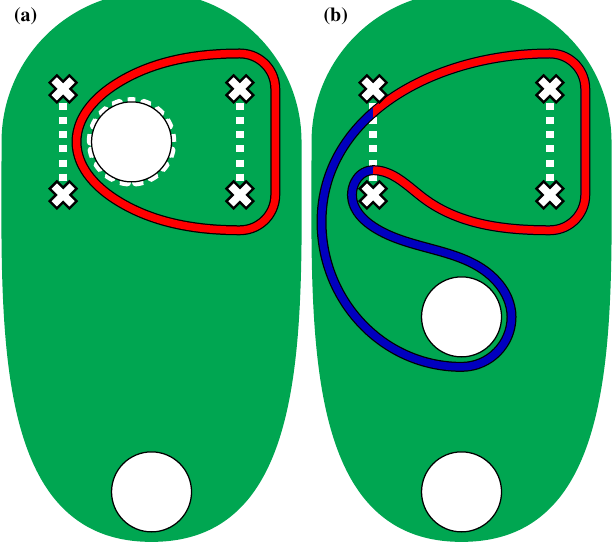
¯ X ¯ X ¯ X C onto C T under the code- ¯ X C is deformed ¯ X ¯ X C T , as we